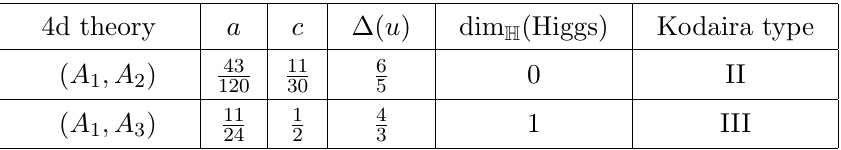
Table 4 . Two simple examples of rank-1 Argyres-Douglas